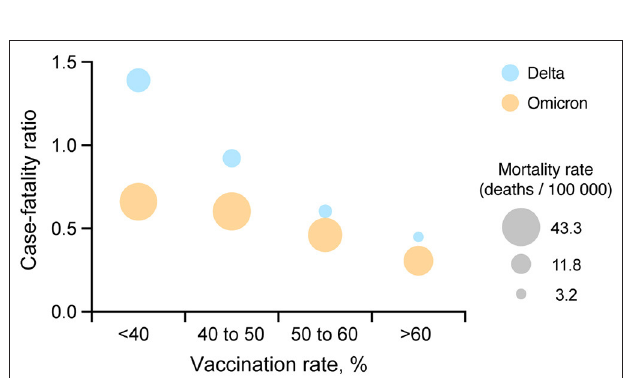
FIGURE 3 | Comparison between COVID-19 case-fatality ratio and vaccination coverage. A multiple variable plot illustrating the COVID-19 case-fatality ratio during the Delta (July 1, 2021 to August 31, 2021; blue circles) and Omicron (December 1, 2021 to January 31, 2022; orange circles) waves for each of the four vaccination rate groups < 40, 40 to 50, 50 to 60% and more than 60% in the